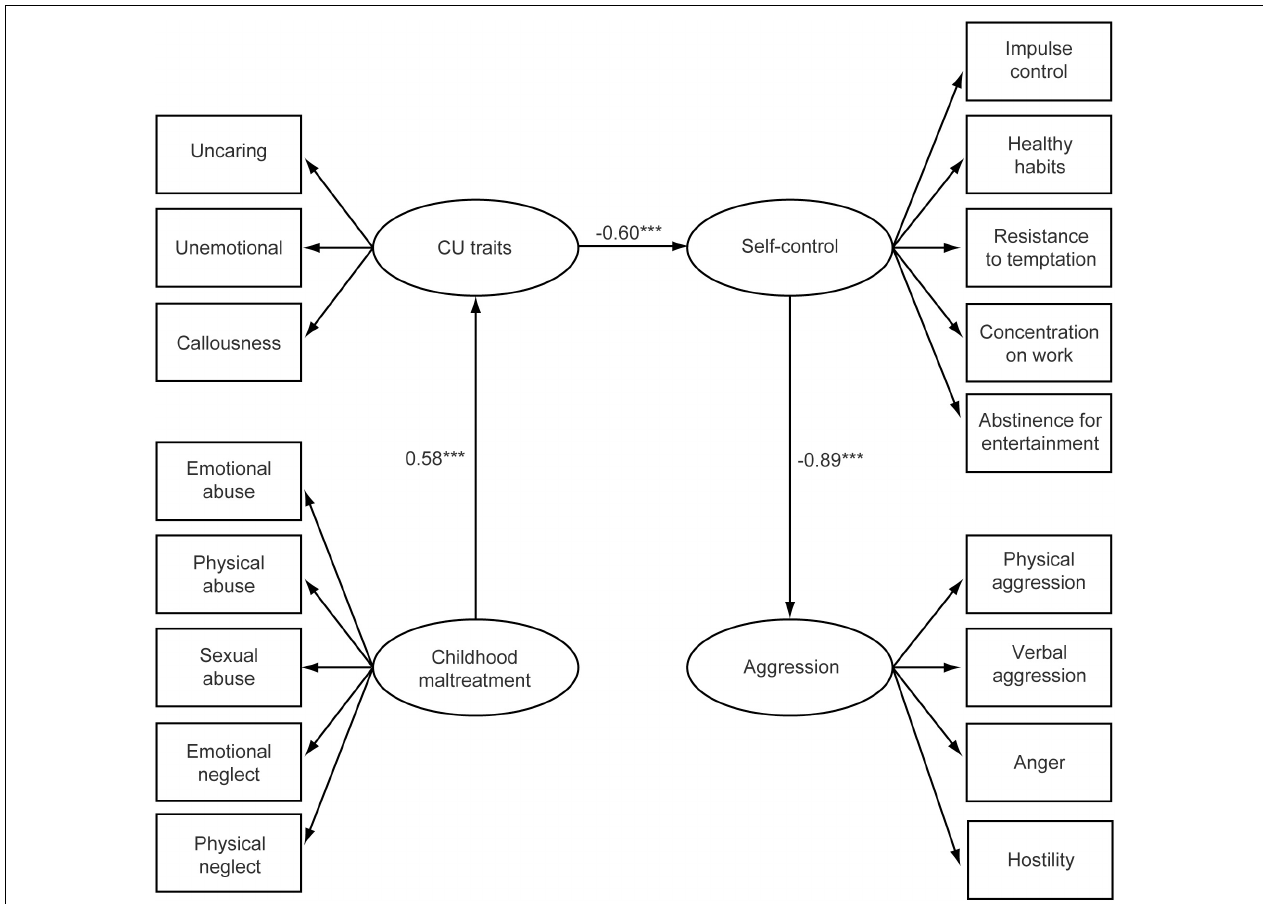
FIGURE 1 | Results from the sequential multiple mediation model. Childhood maltreatment, CU traits, self-control, and aggression are four latent variables in the model. The observed variables that constitute each latent variable are shown in the rectangles. Non-significant paths are omitted, which are the paths from childhood maltreatment to aggression, from CU traits to aggression, and from childhood maltreatment to self-control. *** P < 0.001. CU,